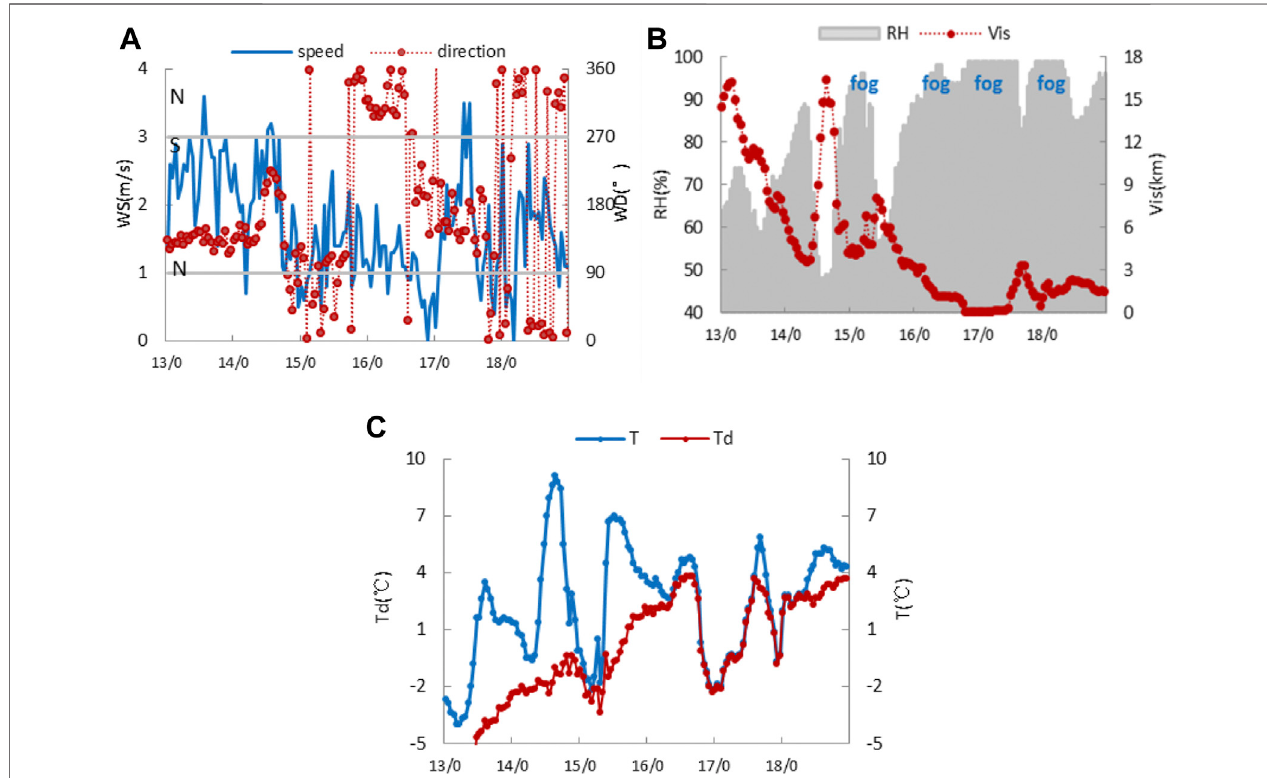
FIGURE8| HourlysurfacemeteorologicalconditionsfromJanuary13toJanuary23,2018atFuyangstationincluding (A) windspeeds(WS),winddirections(WD), (B) relative humidity (RH) and visibility (Vis), (C) temperature (T) and dew point temperature (Td).